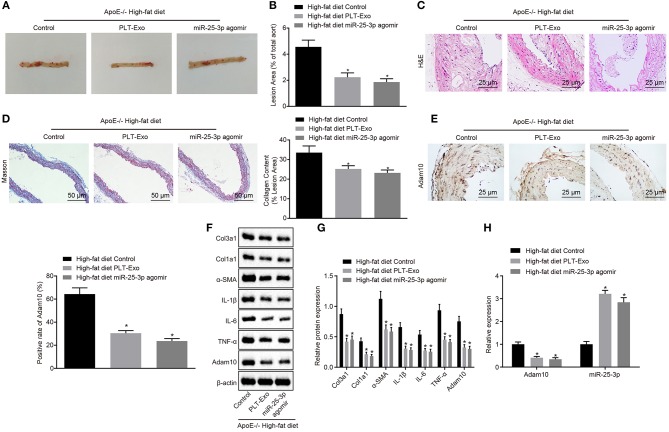
PLT-Exo containing miR-25-3p represses artery plaque formation and attenuates artery inflammation in atherosclerosis mouse models. (A,B) Oil red O staining and quantitative analysis of the whole aorta in response to treatment of PLT-Exo and miR-25-3p agomir (Scale bar = 5 mm). (C) HE staining of the aorta slices (Scale bar = 25 μm) in response to treatment of PLT-Exo and miR-25-3p agomir. (D) Masson staining (Scale bar = 50 μm) to assess collagenous fiber in response to treatment of PLT-Exo and miR-25-3p agomir. (E) Immunohistochemical analysis of Adam10 level in aorta slices in response to treatment of PLT-Exo and miR-25-3p agomir (Scale bar = 25 μm). (F,G) Protein bands and levels of α-SMA, Col1a1, Col3a1, IL-1β, IL-6, TNF-α and Adam10 in the coronary artery in response to treatment of PLT-Exo and miR-25-3p agomir, as determined by Western blot analysis. (H) MiR-25-3p expression and Adam10 level in response to treatment of PLT-Exo and miR-25-3p agomir, as determined by RT-qPCR. *p < 0.05 vs. the high-fat diet control group (ApoE−/− mice treated with high-fat diet). All data are measurement data and expressed as mean ± standard deviation, and data among multiple groups were analyzed using one-way ANOVA. n = 7. The experiment was repeated three times independently.